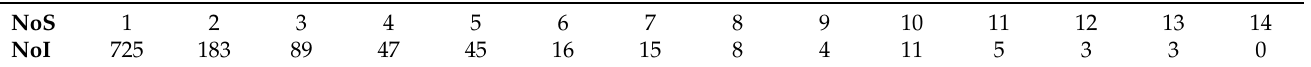
Table 2. Correspondence between NoS and NoI in the SSDD